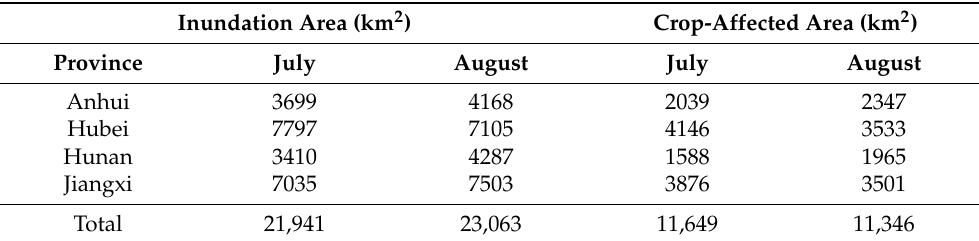
Table 2. Inundation area and crop-affected area (1 km 2 = 100 hectare).